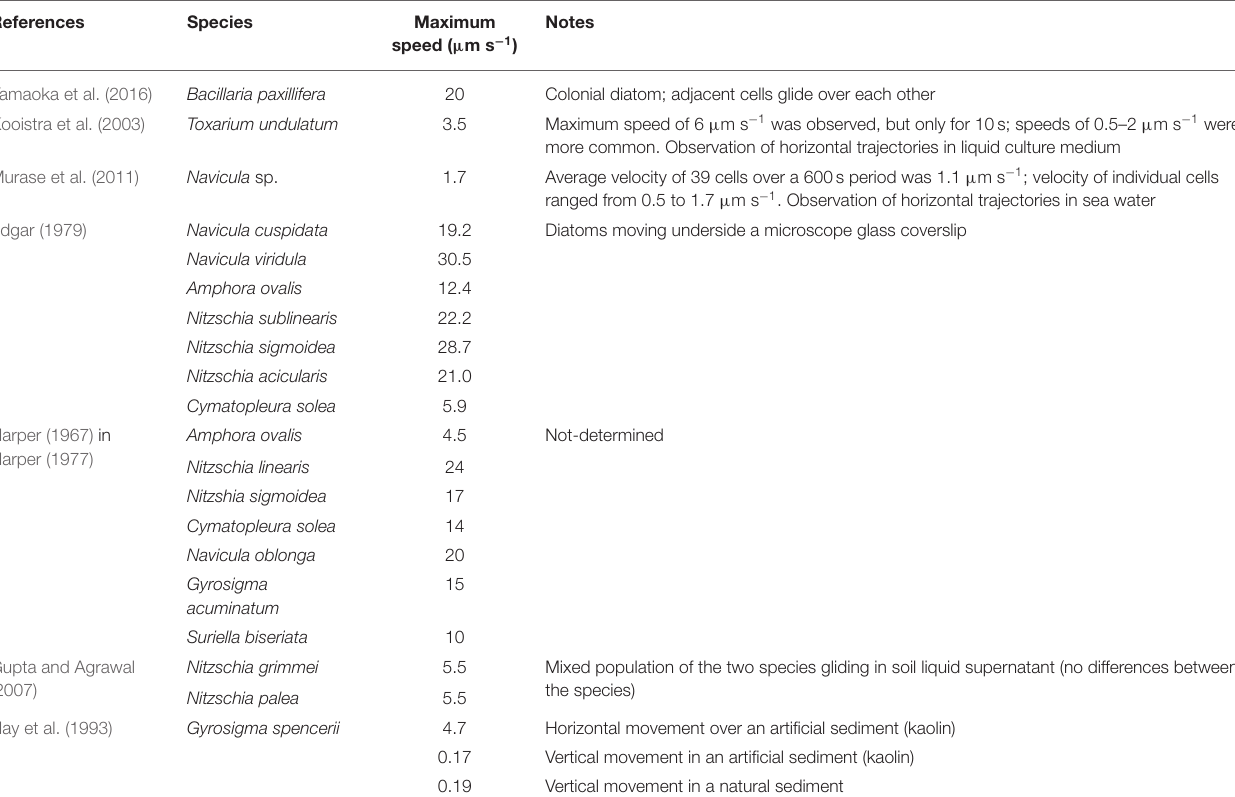
TABLE 1 | Maximum gliding speed of